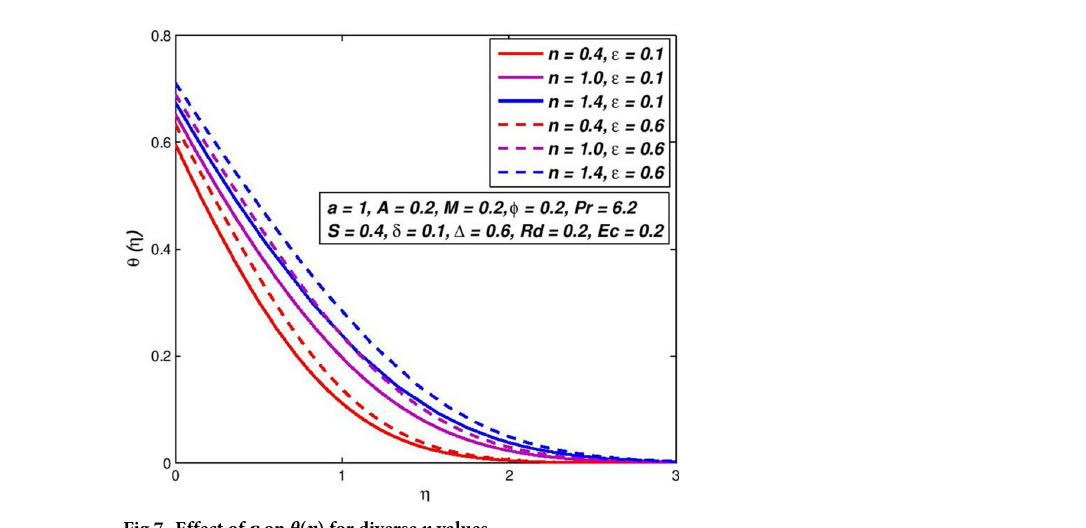
Fig 7. Effect of ε on θ ( η ) for diverse n values.